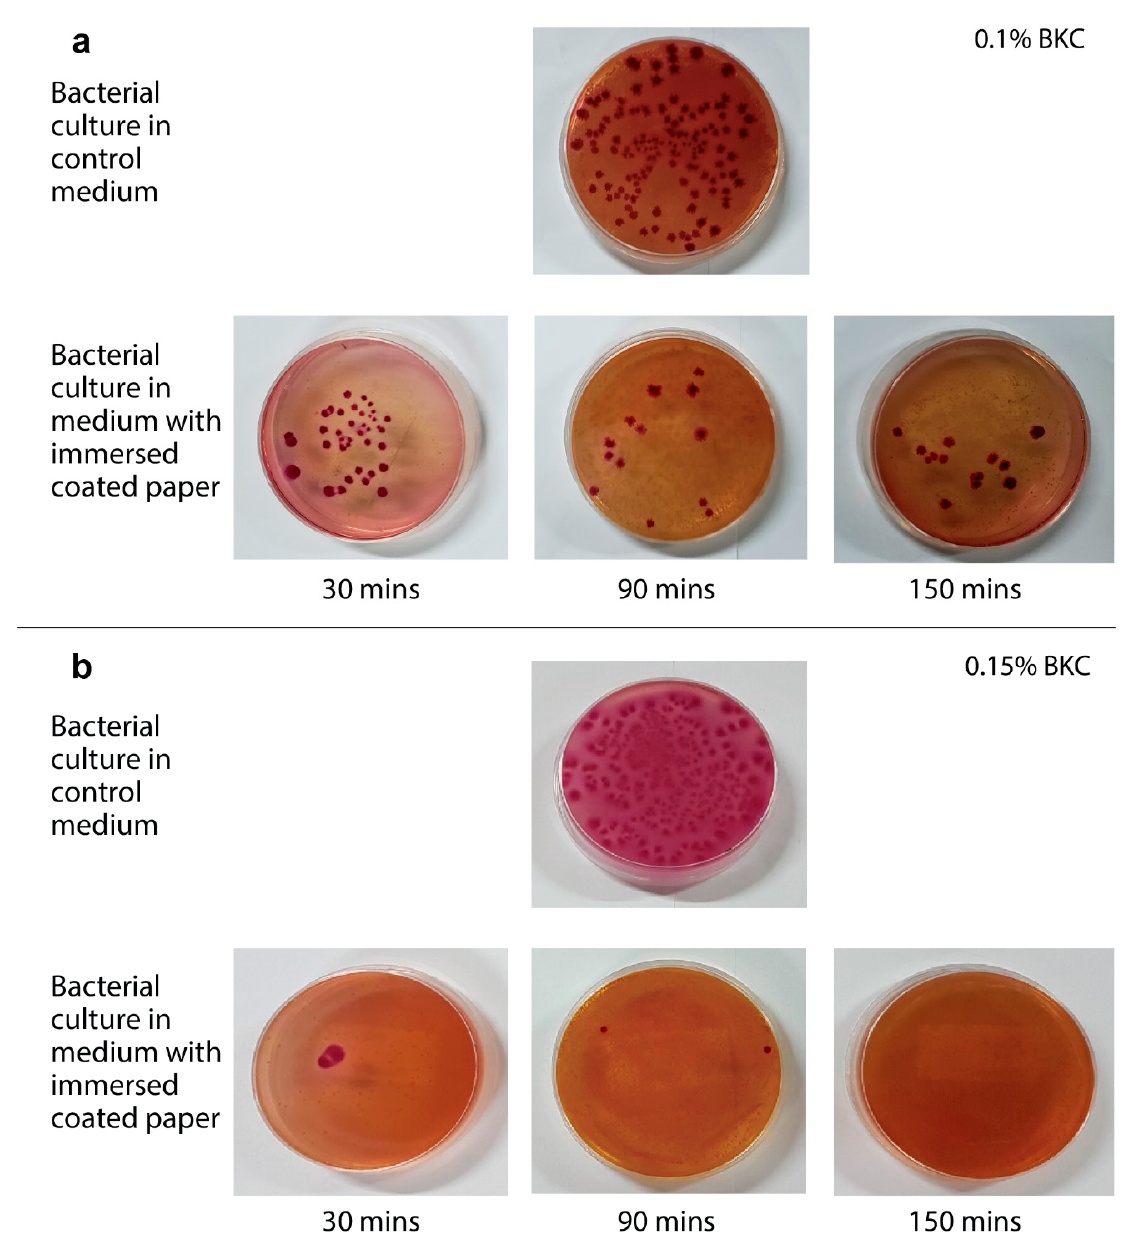
Figure 3. Bacterial cell culture ( E. coli ) in control experiment and against ( a ) 0.1% BKC and ( b ) 0.15% BKC coated paper at different times of exposure.